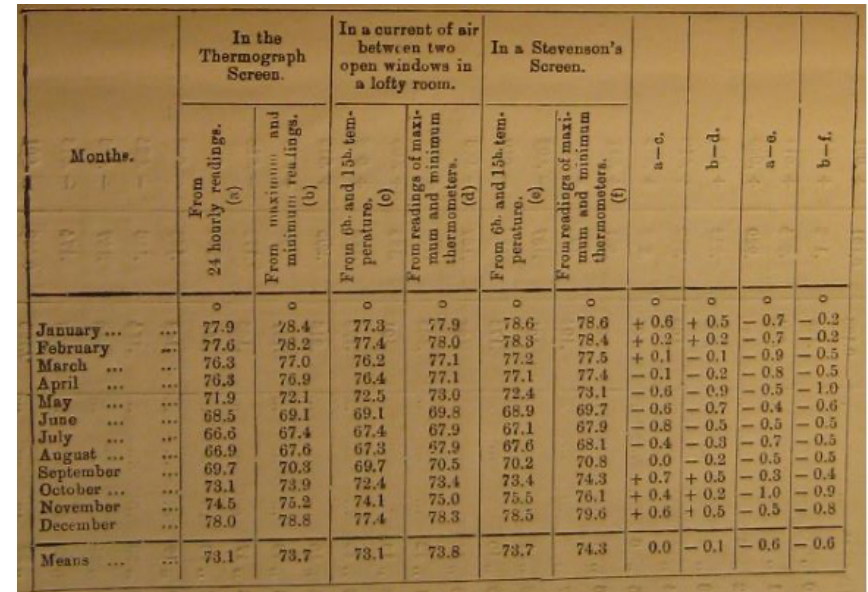
Figure 9. Example of the annual summary sheets found in the logbooks detailing results for three independent measurement techniques aggregated to monthly averages imaged by NOAA NCEI. Temperatures were reported in Fahrenheit to a precision of 0.1 ◦ . Note that each technique had averages measured from both daily maximum and minimum as well as native measurement resolution (hourly for the ther- mograph screen and 06:00 and 15:00LST for the others). There are no obviously available metadata pertaining as to whether maxima and minima were calculated in a consistent